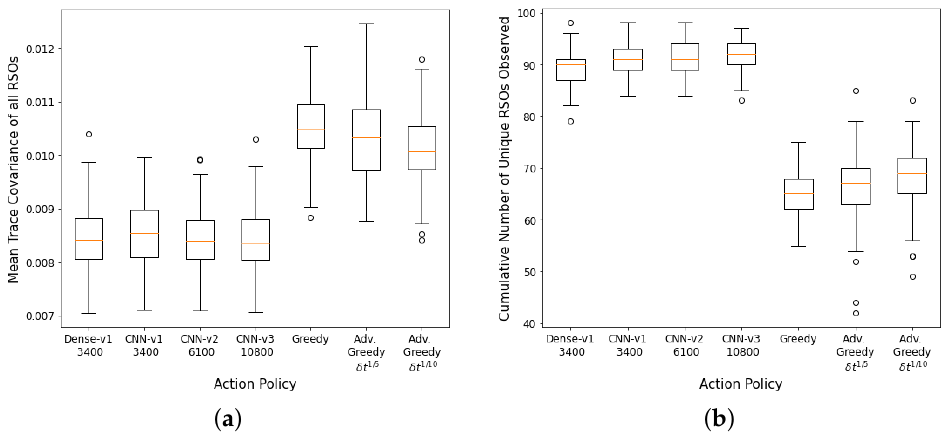
Figure 15. Aggregate performance of the DRL agents with 100 randomly initialized GEO RSOs, evaluated over 100 seeded rollouts of 90 min each and using a ground-based sensor with a faster slew rate of 2.5 s for every 4 ◦ . ( a ) Distribution of the final mean trace covariance at the end of the observation window (lower is better); ( b ) Distribution of the cumulative number of unique RSOs observed at the end of the observation window (higher is better). Note: CNN-v1 3400 represents a CNN-v1 DRL agent trained for 3400 training